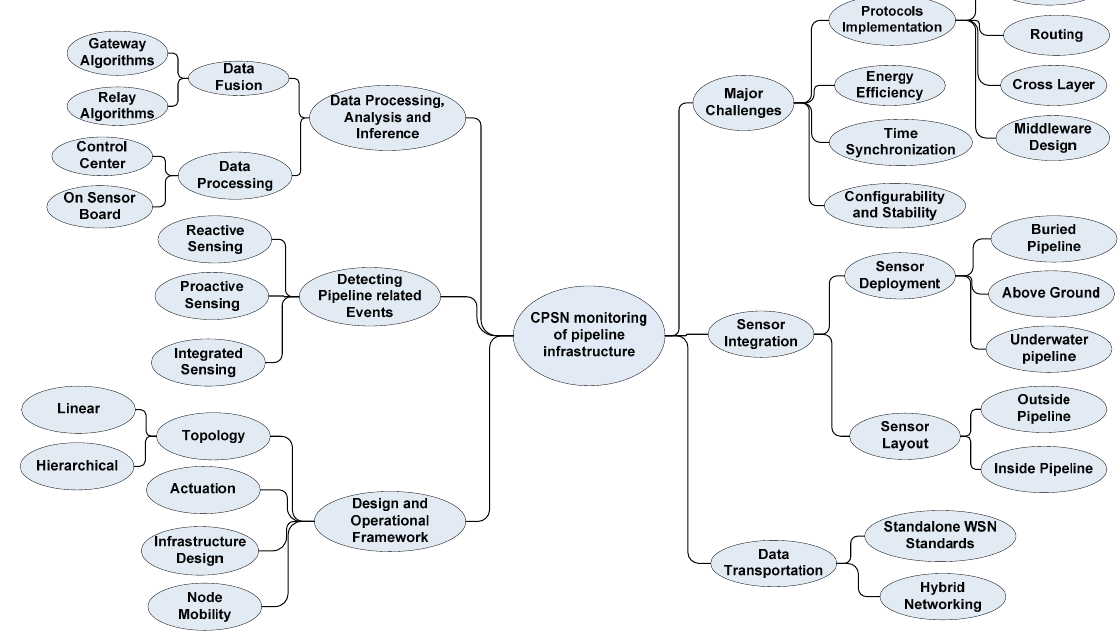
Figure 9. Summary of wireless sensor network based cyber physical monitoring of pipeline